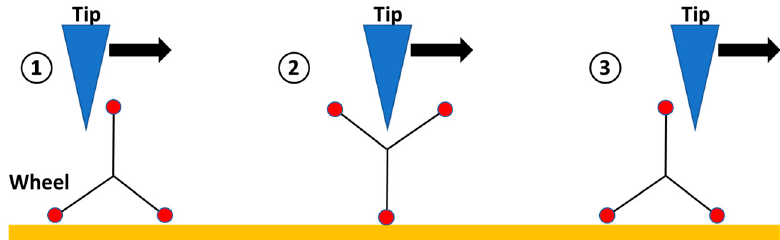
Figure 4. Rotational motion of triptycene wheels. Step 1: the STM tip approaches the molecule; Step 2: the rotation of the wheel starts; Step 3: the STM tip lies on the other side of the wheel after a 120° rotation. Adapted from [25], copyright 2007, with permission from Springer Nature.